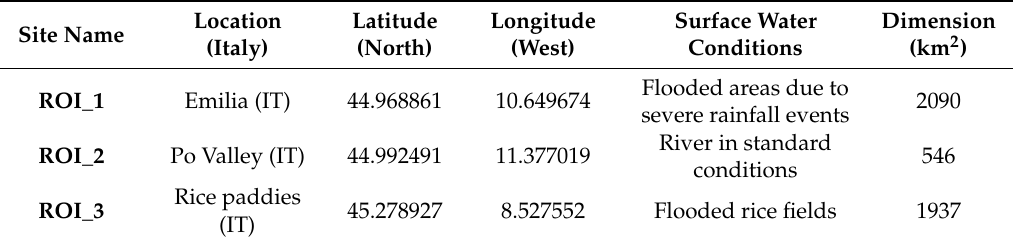
Figure 1. Study sites in Northern Italy with volunteered geographic information (VGI) assumed as the ground truth points (blue: water and red: non-water) used for (i) learning ordered weight averaging (OWA) aggregation and (ii) validation of the algorithm. ROI: region of interest. Table 1. Location / extent of the study sites and characteristics / conditions of the surface water areas. ROI: region of interest.